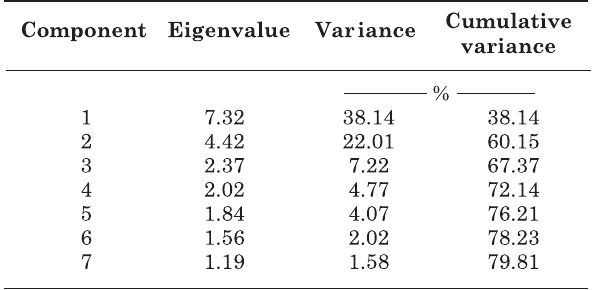
table 2. summary of the main components of the multivariate analysis of soil properties